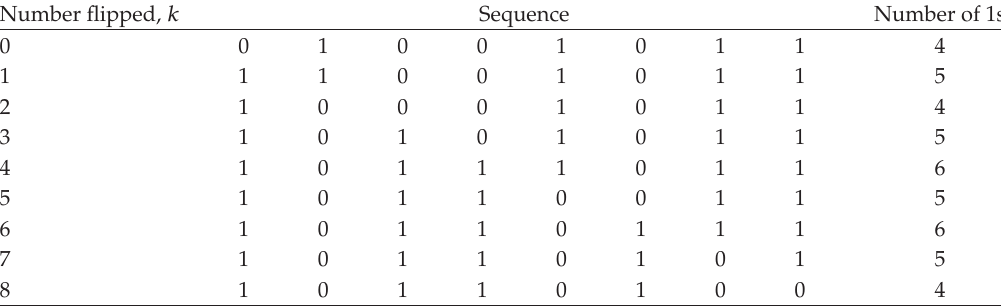
Table 1: Example of the flipping algorithm. The top row is the original